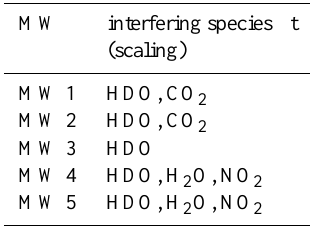
Table 3. Interfering species that have to be taken into account in the 5 candidate micro windows (MW, defined in Table